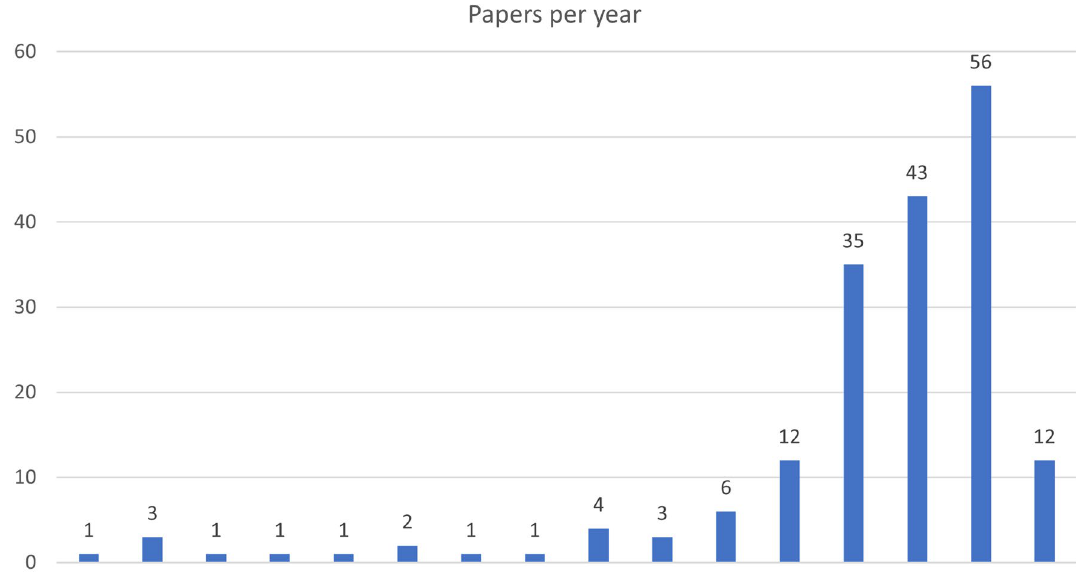
Fig. 1 Annual scientific production: number of papers by year